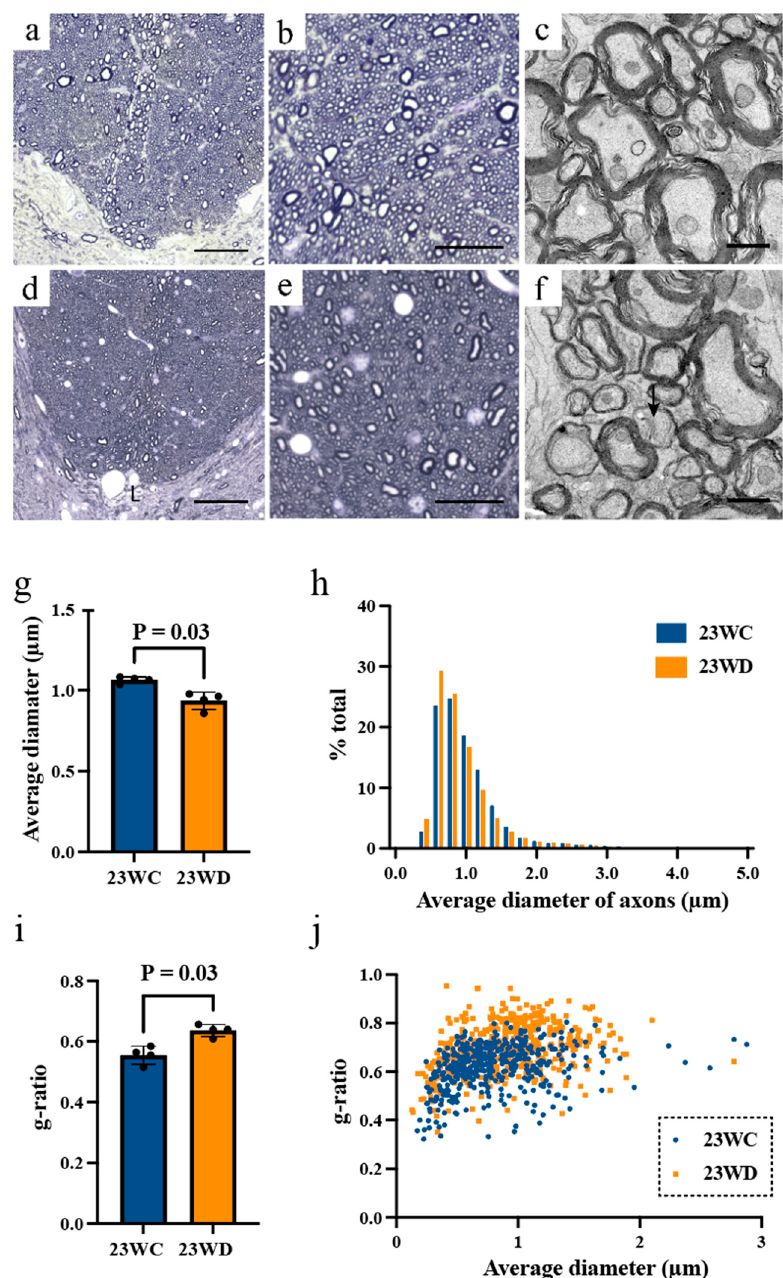
Figure 4. ( a , b ) Optical micrographs of the BDF of the lumbar spinal cord ( a ) and BDF fibers ( b ) in 23WC. ( c ) Electron micrographs of BDF fibers in 23WC. ( d , e ) Optical micrographs of the bottom of the dorsal column of the cervical spinal cord ( d ) and BDF fibers ( e ) in 23WD. ( f ) Electron micrographs of BDF fibers in 23WD. The arrow indicates a demyelinating axon. The scale bar indicates 100 µ m ( a , d ), 10 µ m ( b , e ), and 1 µ m ( c , f ). ( g ) Average diameter of BDF axons. The axons were significantly smaller in 23WD ( p < 0.05, Mann–Whitney U test). ( h ) Size distribution of BDF axons in the lumbar cord in 23WC (n = 10,220 axons) and 23WD (n = 9630 axons). The Kolmogorov–Smirnov test revealed a significant ( p < 0.0001) between-group difference. ( i ) g-ratio of BDF fibers. In 23WD, the g-ratio was significantly higher than in 23WC ( p < 0.05, Mann–Whitney U test). ( j ) The relationship between axonal diameter and the g-ratio in 23WC (n = 439 fibers) and 23WD (n = 438 fibers). In 23WD, the g-ratio of some BDF fibers increased independent of axonal diameter. Abbreviations: BDF, base of the dorsal funiculus; 23WC, control animals at 23 weeks after sham diabetes induction; 23WD, diabetic animals at 23 weeks after diabetes